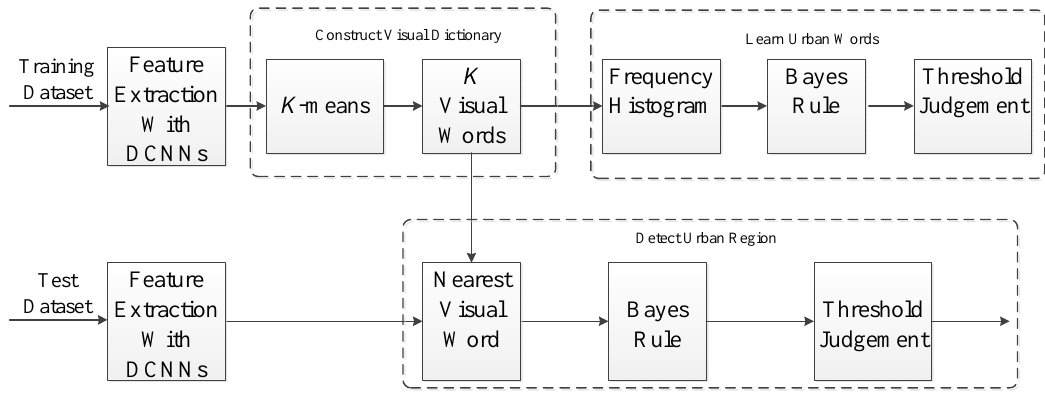
Figure 1. Algorithm flow of our proposed urban area detection